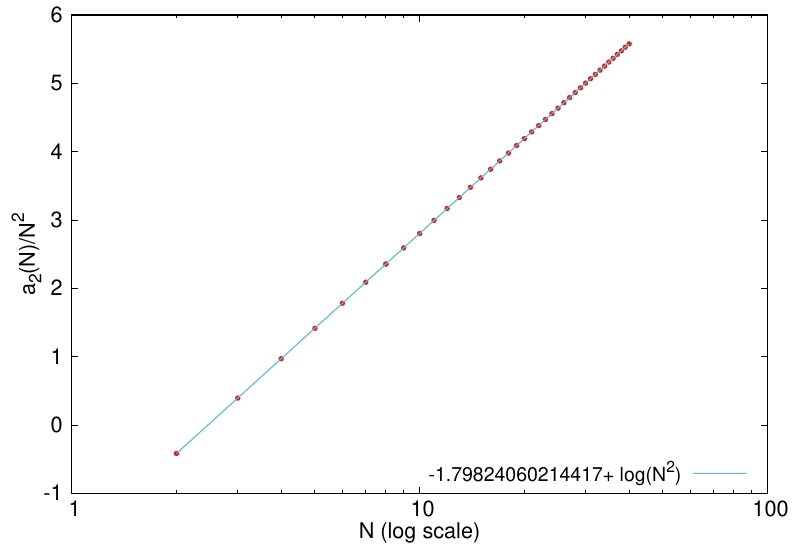
Figure 8. Dependence on N of the coe(cid:14)cient a 2 ( N ) =N 2 appearing in eq.